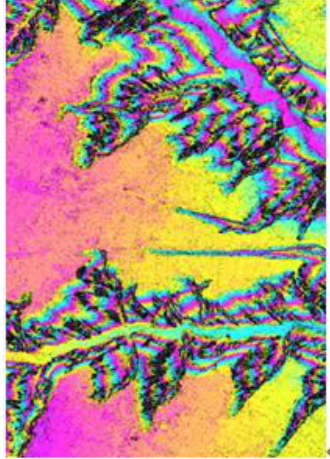
Figure 7. Interferogram after adaptive filtering